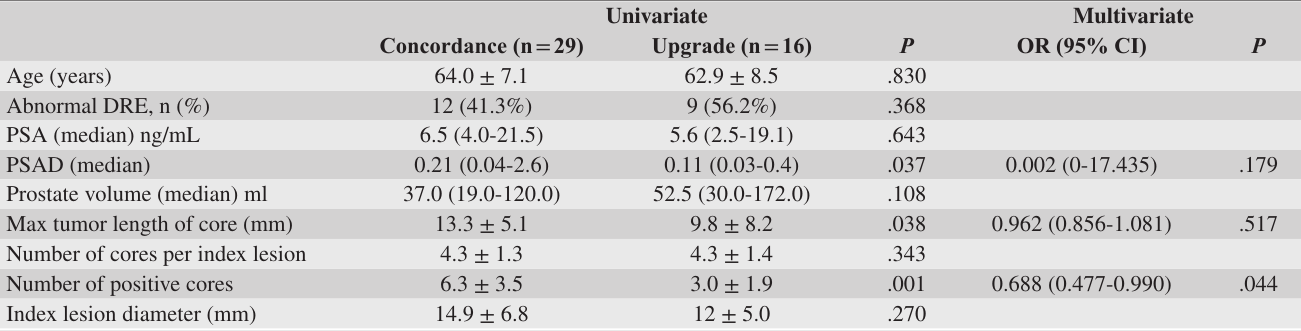
Table 4. Univariate and Multivariate Analysis of Possible Predictors for Concordance and Upgrade in Cognitive-Fusion Biopsy